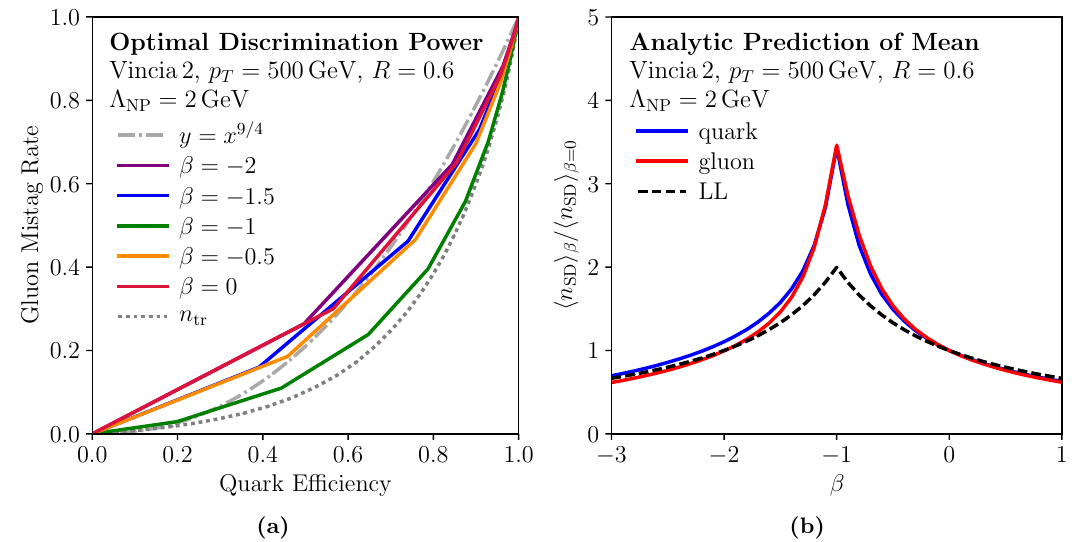
Figure 9. (a) Discrimination power of soft drop multiplicity as a function of (cid:12) , with the optimal (perturbative) values of z cut and (cid:18) cut computed from eqs. (3.17), (3.18) and (3.20) using (cid:3) NP = 2 GeV. (b) Ratio of mean n SD as a function of (cid:12) to mean n SD at (cid:12) = 0. The Vincia results for quarks and gluons agree with the double log prediction from eq. (3.22), except near (cid:12) = nonperturbative e(cid:11)ects become